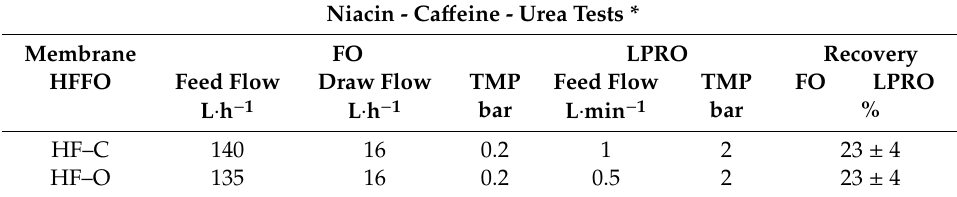
Table 4. Operational parameters used for the membrane rejection analysis of niacin, ca ff eine, and urea in FO and low-pressure reverse osmosis (LPRO) processes. The parameters were modified to maintain the same process recoveries between the experiments. HF–C, chlorinated membrane; HF–O, original membrane.